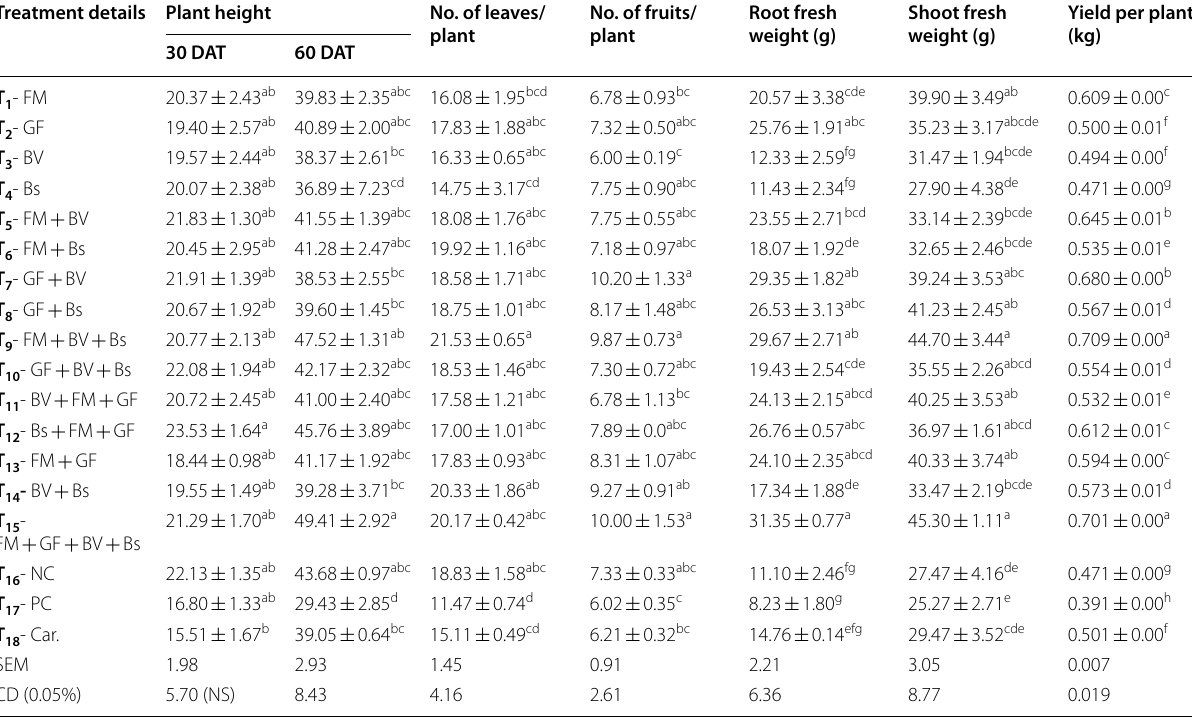
Values with different letter(s) within a column are significant at p< 0.05 by Duncan’s multiple range test (DMRT), Values are the means ( replicates